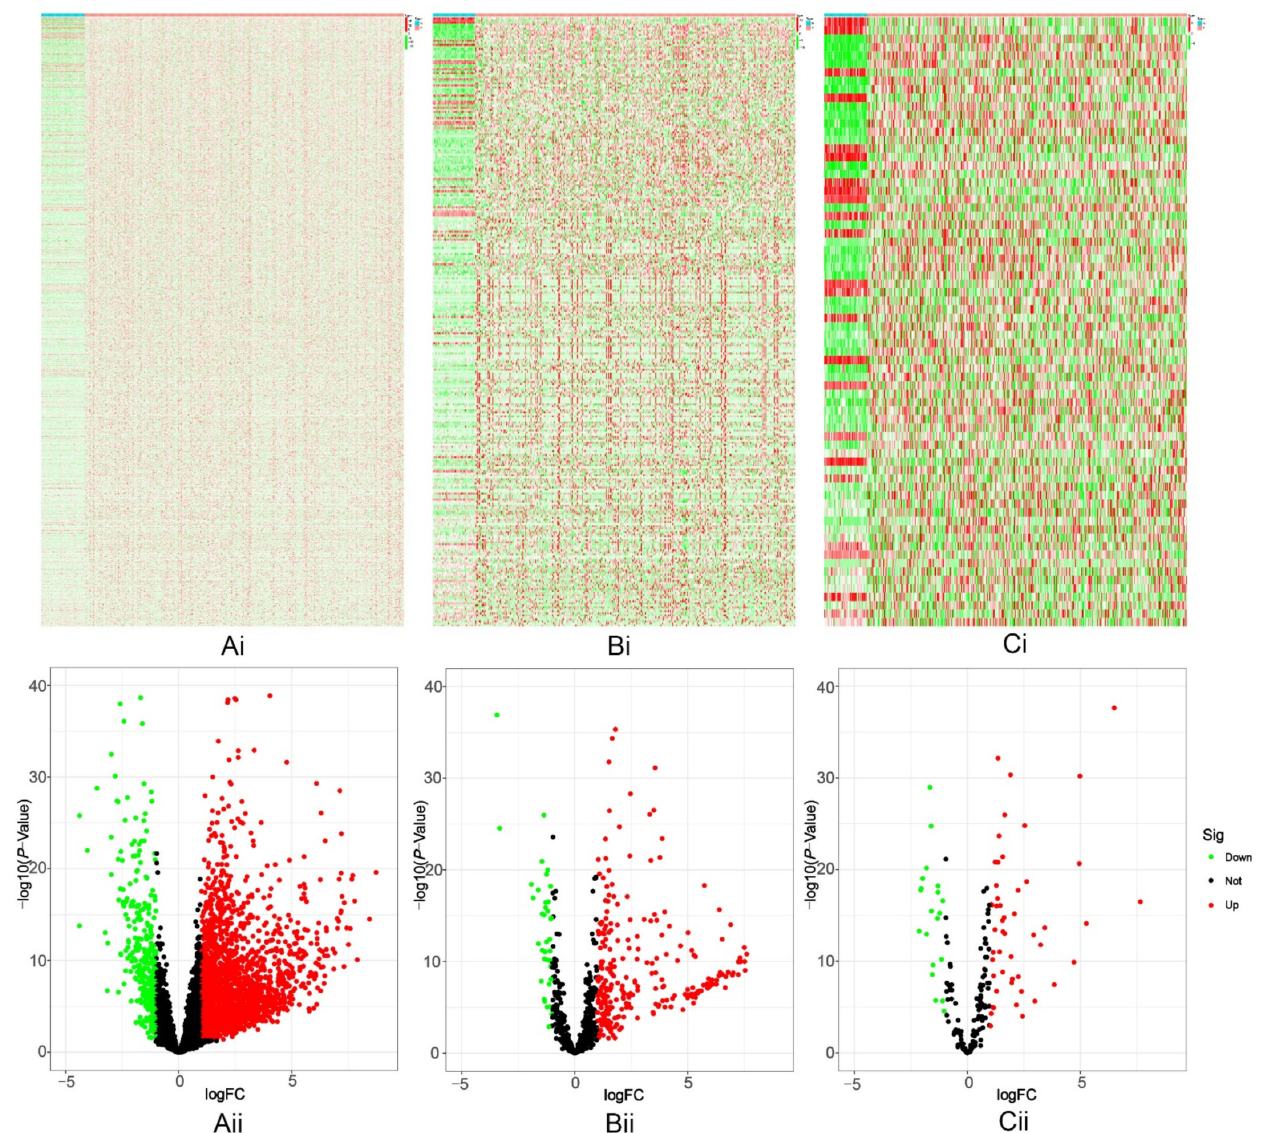
Figure 2. Identification of differentially expressed lncRNAs, miRNAs, and hypoxia-related mRNAs in human hepatocellular carcinoma. ( Ai – Ci ): Heatmap. ( Aii – Cii ): Volcano plot. The red/green dots denote statistically significantly up-/down-regulated lncRNAs, miRNAs, and hypoxia-related mRNAs, respectively. The black dots denote non-differentially expressed